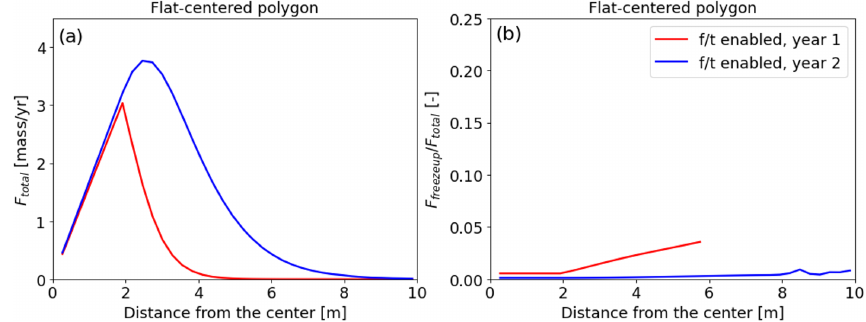
Figure 6. (a) The total flow rate ( F total ) represents the tracer flow rates integrated over the vertical cross-section of the flat-centered polygon and over the entire year at different distances from the center. (b) The proportion of tracer flow rate during the freeze-up period relative to the total flow rate at different distances from the center of the flat-centered polygon. F freezeup represents the tracer flow rates integrated over the vertical cross-section of the flat-centered polygon and over the freeze-up period at different distances from the